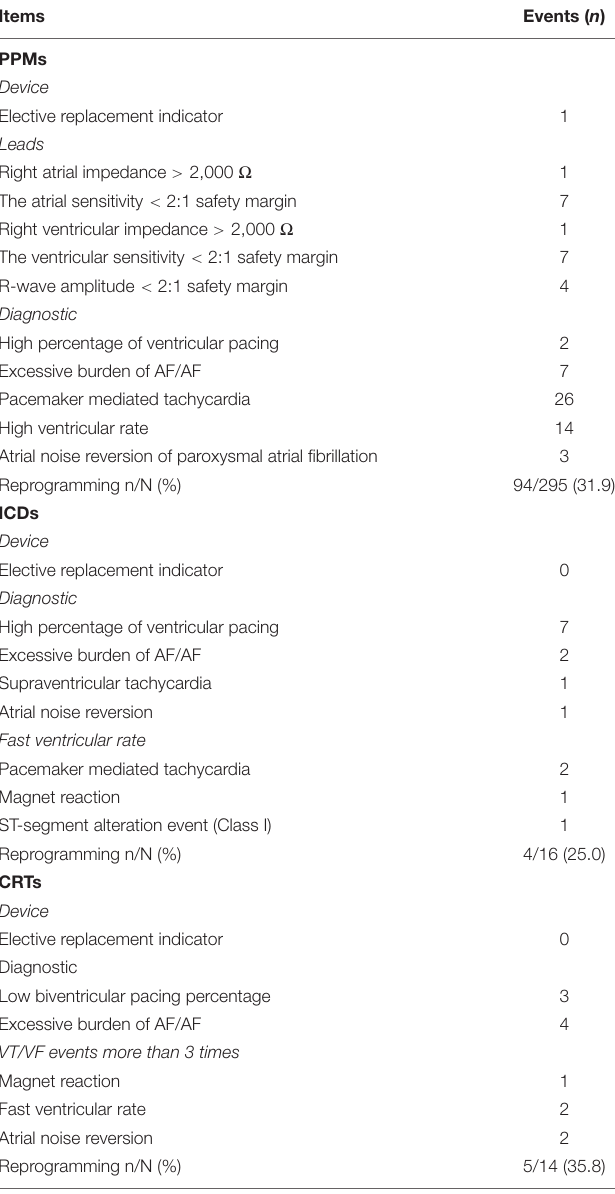
TABLE 3 | Alert messages for each cardiac implantable electronic device groups. TABLE 4 | Remote reprogramming performed in each cardiac implantable electronic device